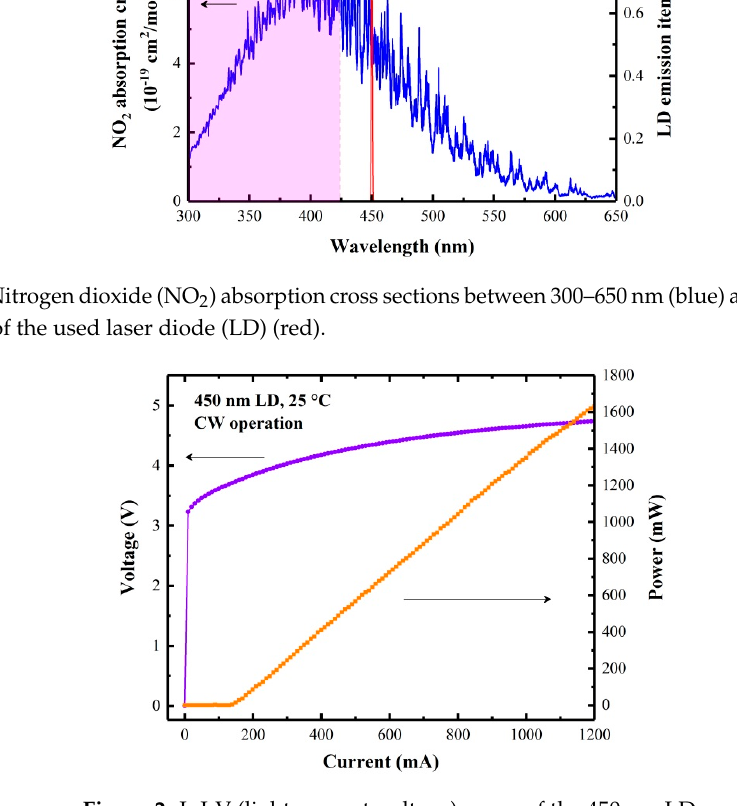
Figure 2. L-I-V (light-current-voltage) curve of the 450 nm LD.